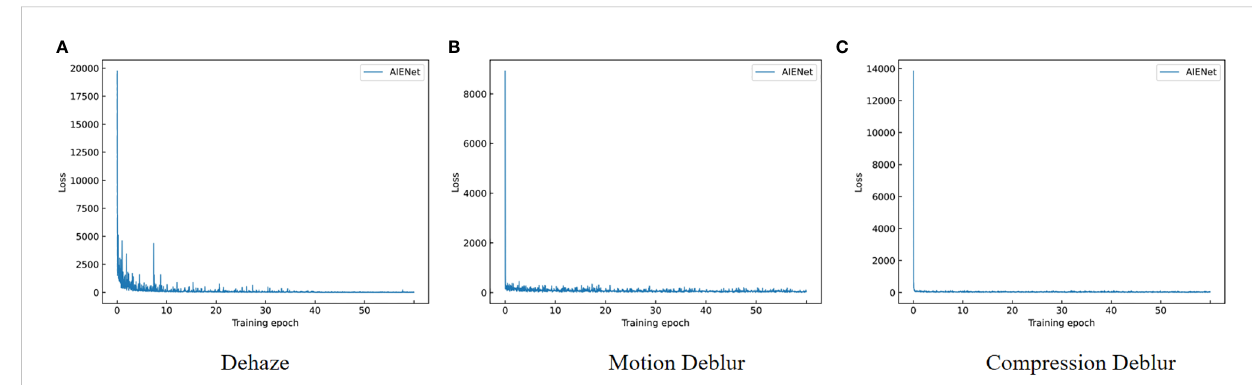
FIGURE 4 Curves of the changing trend of target loss. (A) shows the trend of the dehazing loss function, (B) shows the trend of the compression deblurring loss function, and (C) shows the trend of the motion deblurring loss